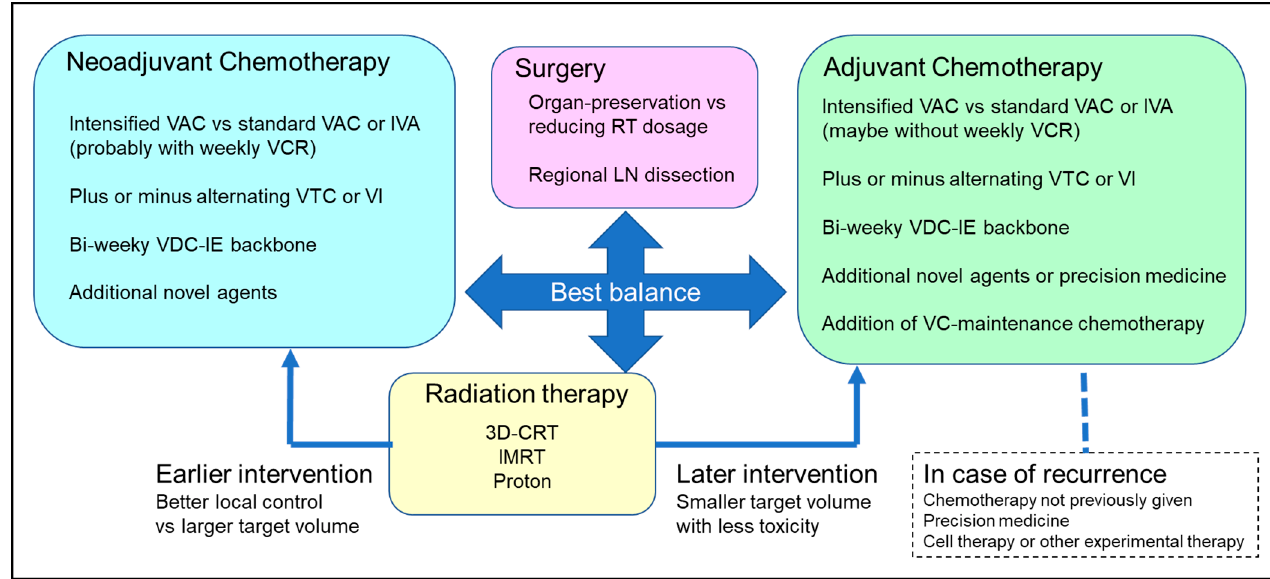
Figure 3. Basic structure of multimodal therapy for RMS and key clinical issues. Although each clinical question should be answered by conducting a well-designed clinical trial, the physician is responsible for selecting the optimal strategy in the real-world setting. 3D-CRT, three-dimensional conformal radiotherapy; IMRT, intensity-modulated photon radiotherapy; IE, ifosfamide,